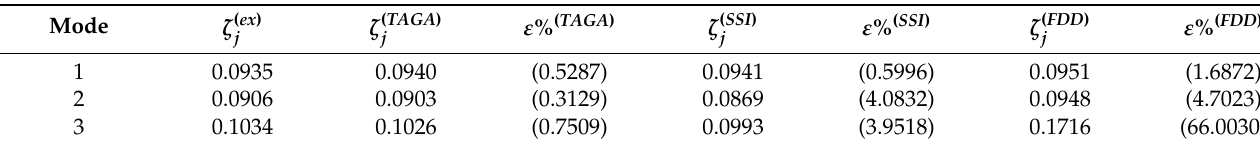
Table 4. Exact damping ratios, identified damping ratios, and corresponding discrepancies for the 3DoF system.